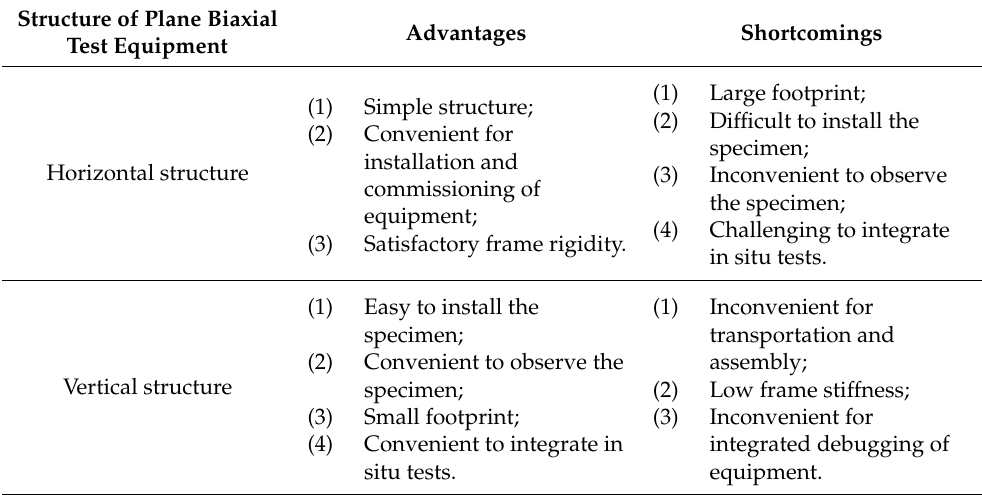
Table 2. Advantages and disadvantages of vertical and horizontal structure plane biaxial test- ing